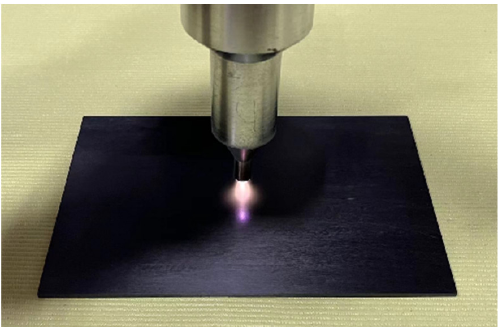
Figure 2. Surface of composite laminates treated with plasma.